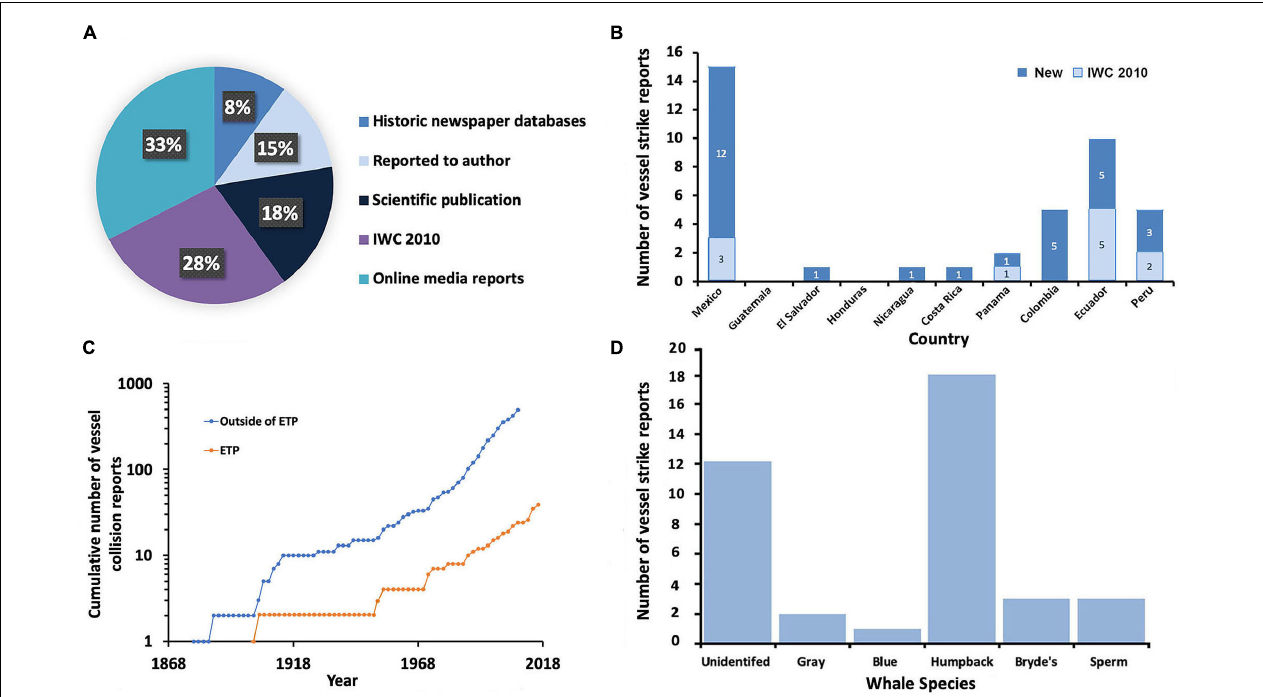
FIGURE 3 | (A) The proportion of whale strike records found in this study from different evidence sources. (B) The number of vessel strike reports from each of the countries of the ETP. Reports that were discovered in this analysis are marked as “New” (dark blue) and reports from the IWC Ship Strike Database as “International Whaling Commission (IWC), 2010” (light blue). (C) A comparison of the cumulative number of ETP vessel strikes from this study and those from the rest of the world (International Whaling Commission (IWC), 2010) over-time. Data was pooled into two-year blocks of time. (D) The frequency that large whale species were reported to be involved in vessel strikes in the ETP in this